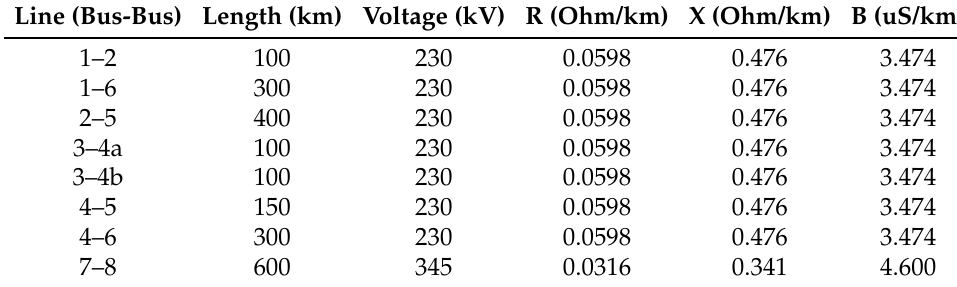
Table A3. Transmission line data of the utility